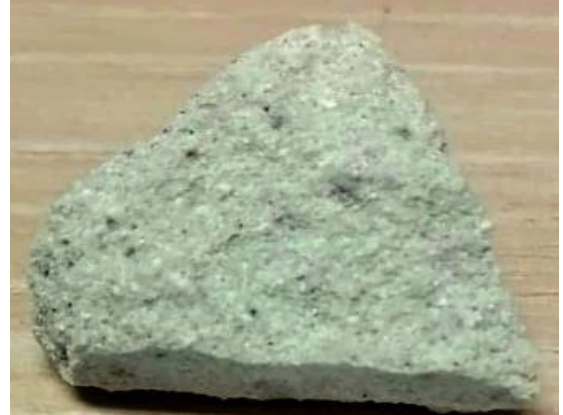
Figure 4. Fragment of brick made with 90 wt% glass sand (GS).